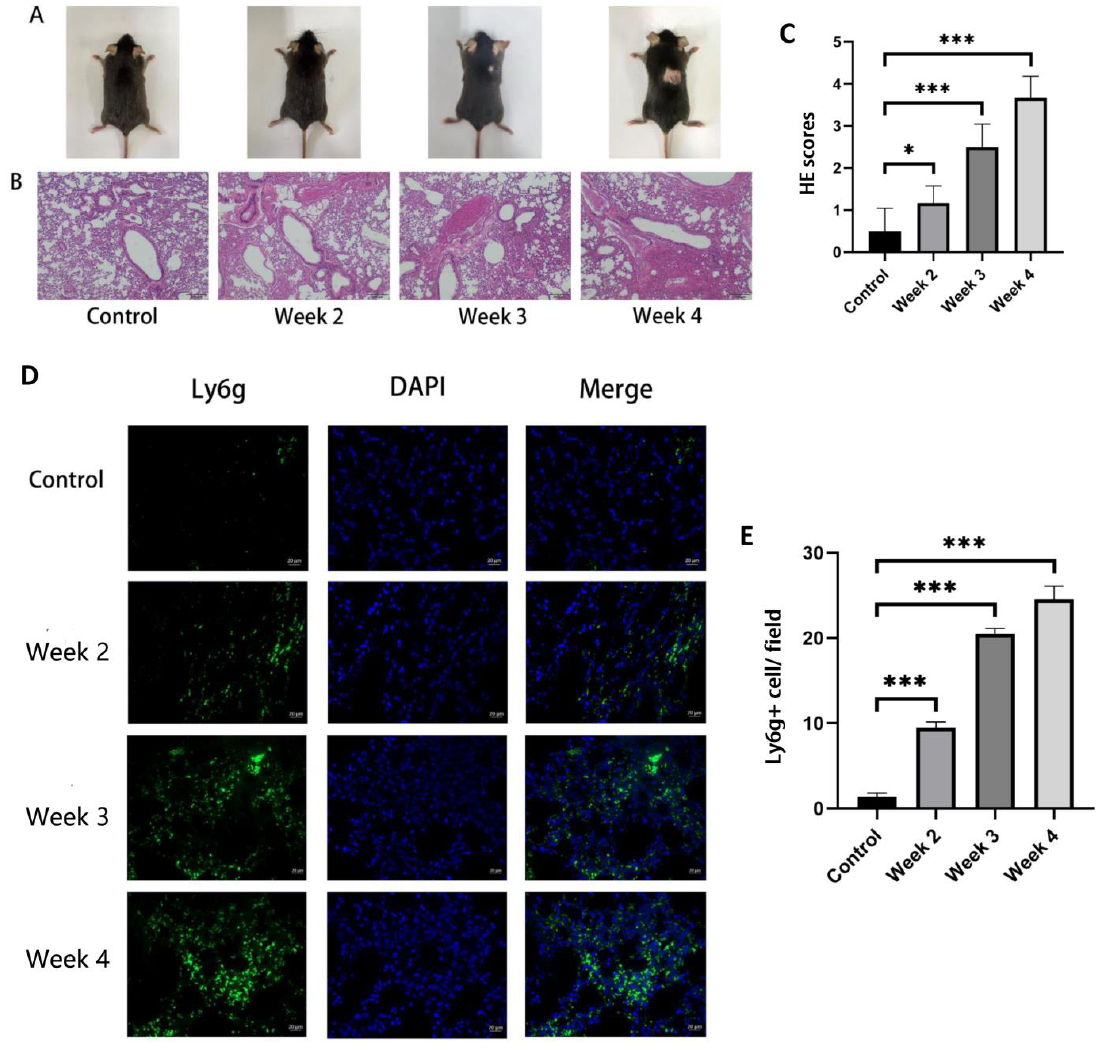
Figure 4. The change in fur appearance of the mice and the level of inflammatory cell infiltration in their lung tissue before and after irradiation. The mice in the control group did not receive irradiation, while the mice in the irradiation group were detected at 2, 3 and 4 weeks after irradiation. ( A ) After irradiation for 3–4 weeks, the back of mice showed hair loss. ( B , C ) H&E sections and inflammation scores of the lung tissues showed that inflammatory cell infiltration appeared in the lungs of irradiated mice with a time- dependent trend (bars, 200 μm). ( D ) Immunofluorescence of neutrophil Ly6g staining (green fluorescence) and DAPI nuclei staining (blue fluorescence) (bars, 20 μm). ( E ) Quantification of Ly6G (+) neutrophils per field of view. All graphs show the means ± SEM of at least three independent experiments. Statistical significance was analyzed by two-tailed t -test, * p < 0.05 and *** p < 0.001 compared to control.